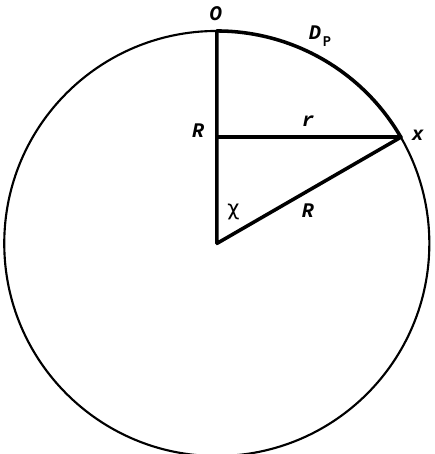
Fig. 1.— Although the corresponding definitions are valid for models with k of 0 and − 1 as well, easiest to visualize are distance definitions for the case k = +1. The universe can be thought of as a curved three-dimensional space, corresponding to the circle. Two dimensions are hence suppressed, so that the two dimensions in the plane of the figure can show the universe and its spatial curvature. R is the scale factor of the universe, as usual chosen to correspond to the radius of curvature. The observer is located at the top of the circle at O and observes an object located at x . D P , the length of the arc, is the proper distance to that object. For η = 1, the angular-size and luminosity distances (as well as other distances not discussed here such as the proper-motion distance and parallax distance) depend on r = R sin( χ ) in a relatively simple manner (see KHS). Note that χ is constant in time; one can use it or σ = r/R , which is also constant in time, as the basis for a so-called co-moving